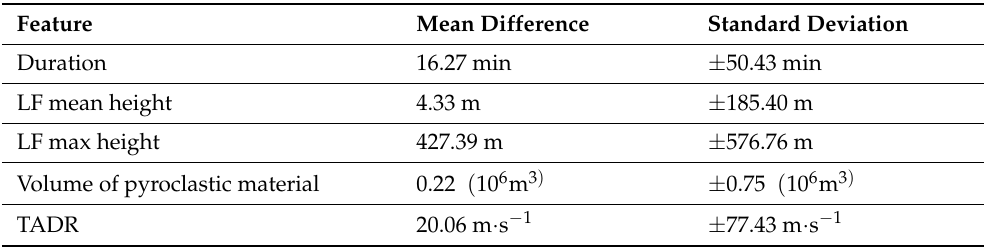
Table 1. Numerical values for the mean difference and the standard deviation comparing the manual and automated procedures of pyroclastic material volume calculation.